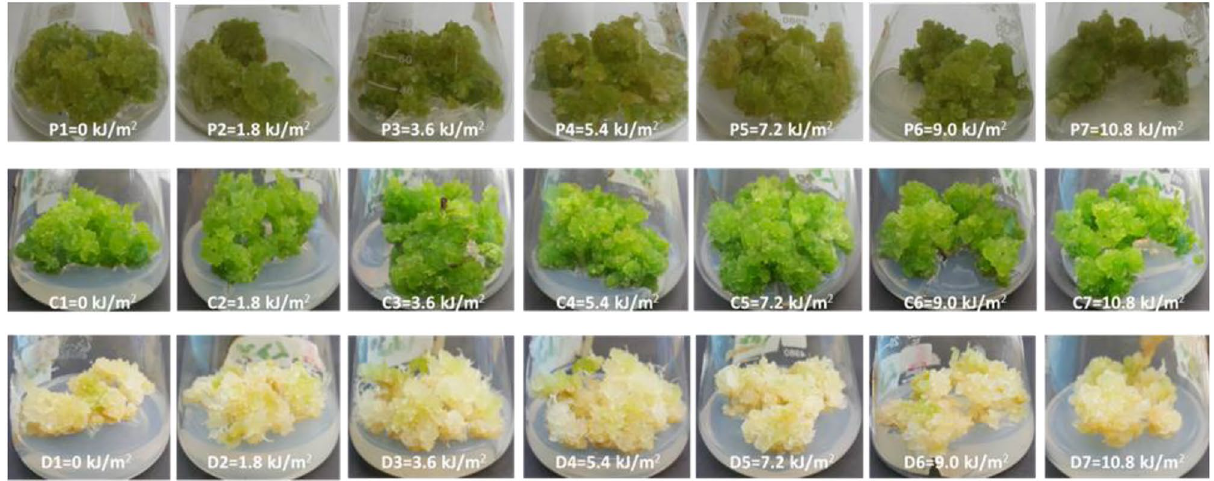
Figure 2. Combinatorial effects of UV-C treatments (0–10.8 kJ/m 2 ) on morphology of callu cultures of F. indica grown for 30 days under light regimes; ( a ) P1–P2 stands for UV-C treated cultures in photoperiod (16L/8D h), ( b ) C1–C7 represents UV-C elicited cultures in cont. light (24 h) and ( c ) D1–D2 shows UV-C mediated cultures in complete dark (24 h).